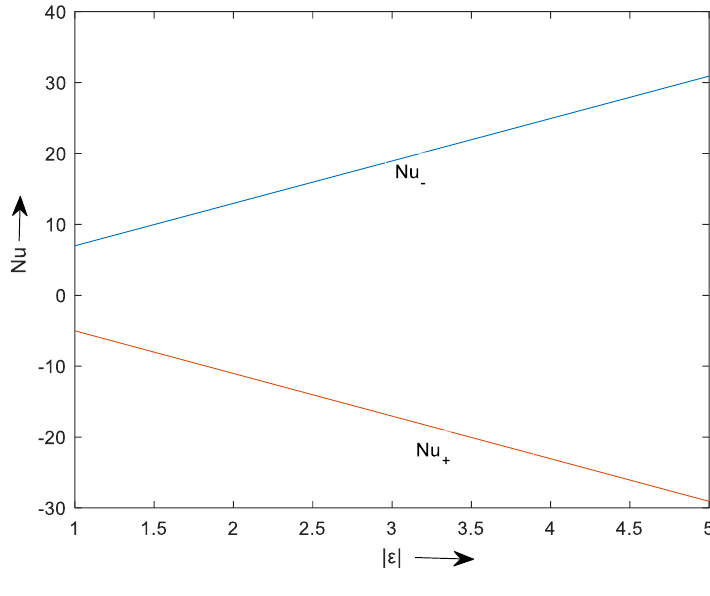
Fig. 8. Nusselt number Vs ∣ ɛ